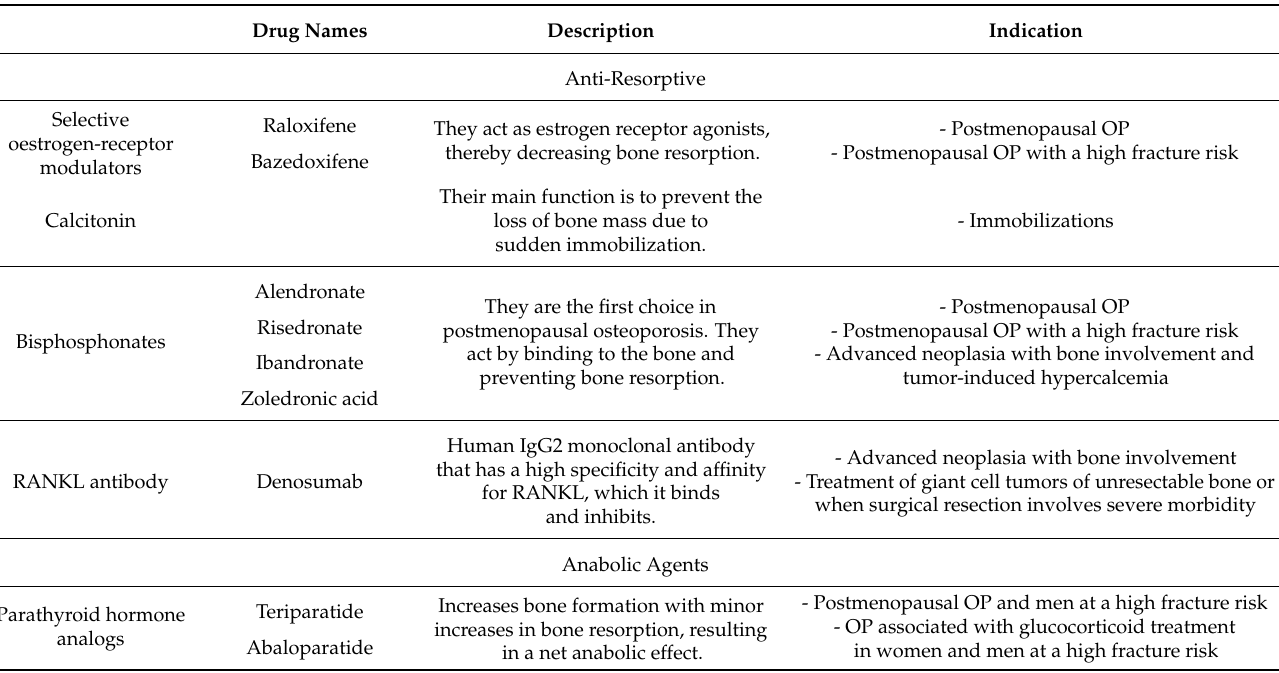
Table 1. Drugs for the treatment of